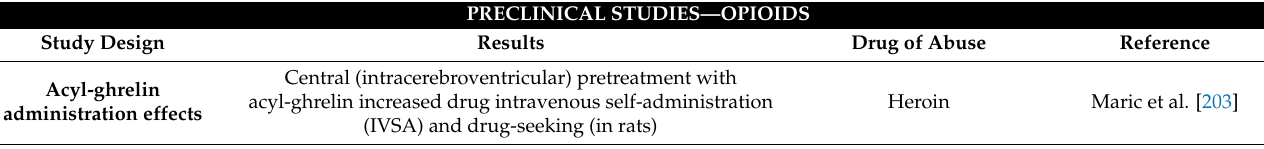
Table 3. Ghrelin/GHS-R1As and opioids plus Ghrelin/GHS-R1As and cannabinoids—preclinical and clinical studies